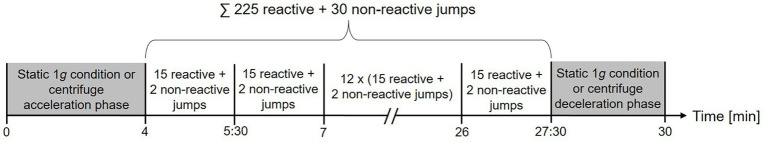
Timeline of the three jumping protocols. To make the three protocols comparable, we adhered to the schedule set by the centrifuge protocol: 4 min of getting the centrifuge ready and set to the correct g-level, followed by 15 series of 15 jumps each and a deceleration period of 2 min 30 s at the end. One series of jumps lasted 1 min 30 s, consisting of approximately 12 s of jumping, followed by approximately 75 s of rest.